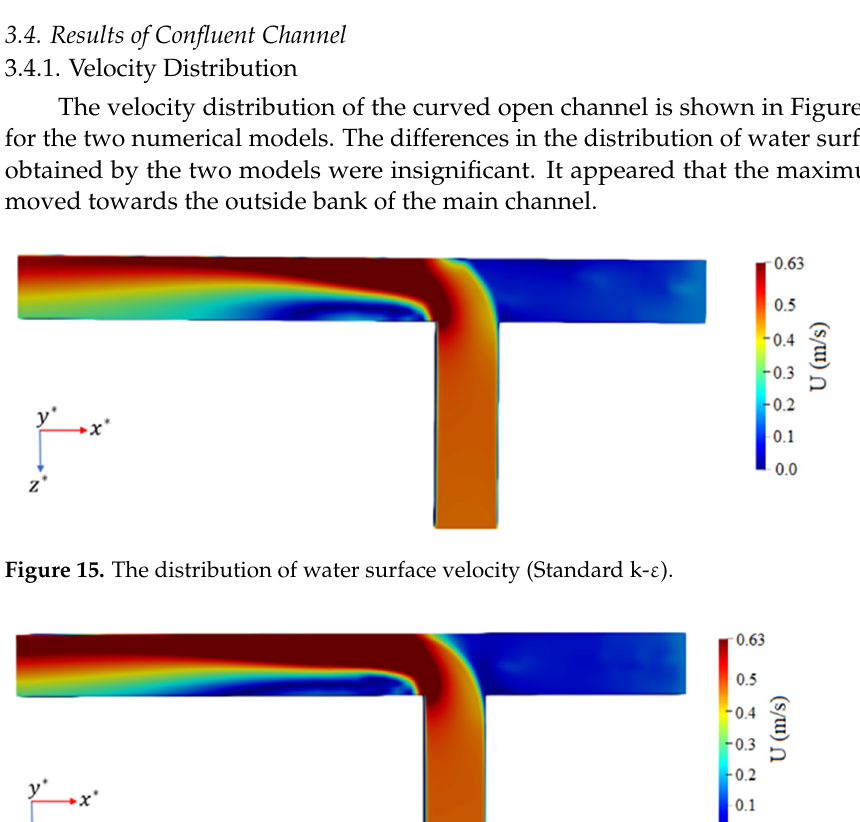
Figure 14. The refined mesh.